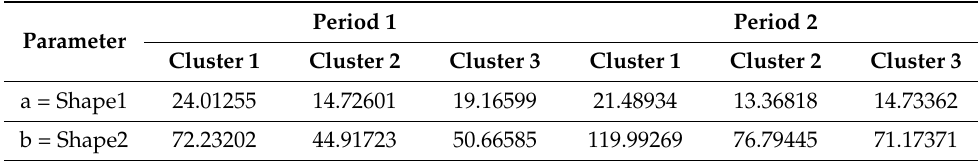
Table 17. Estimated parameters for the beta distribution of k u2 .